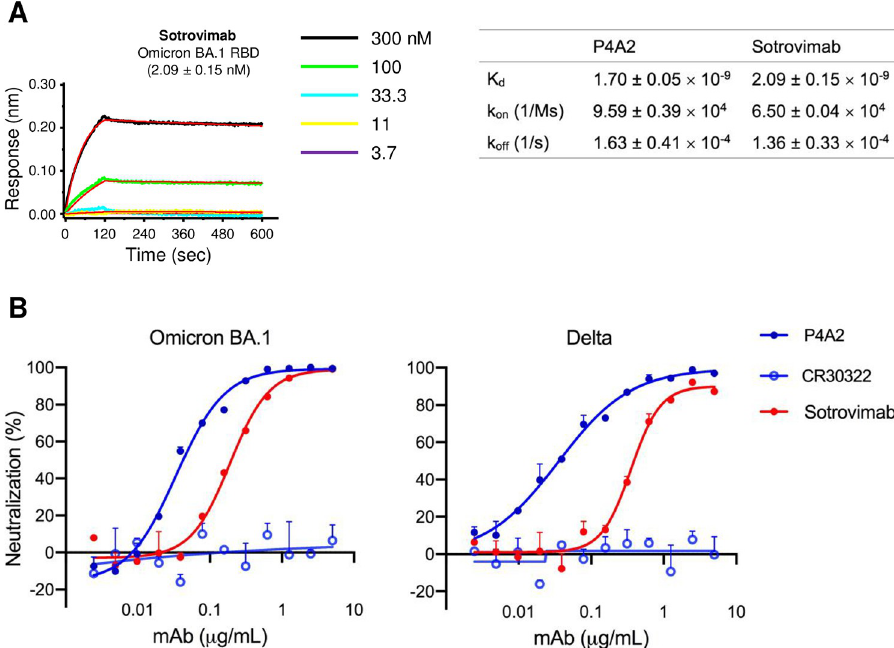
Fig 3. Neutralization potential of P4A2 mAb against Omicron BA.1 variant. (A) Sotrovimab was immobilized on anti-human Fc biosensor and tested using three-fold serial dilutions of RBD (starting with 300 nM and going down to 3.3 nM; the five concentrations tested are indicated). Data shown is after the reference was subtracted and aligned using Octet Data Analysis software v11.1 (Forte Bio). Curve fitting was done with a 1:1 binding model, and k on , k off and K d values were calculated using a global fit. (B) Neutralization of authentic SARS-CoV-2 BA.1 and Delta by P4A2 and Sotrovimab was determined using focus-reduction neutralization assay. CR3022 mAb was used as the negative control. Neutralization assays were done in duplicates and repeated at least three